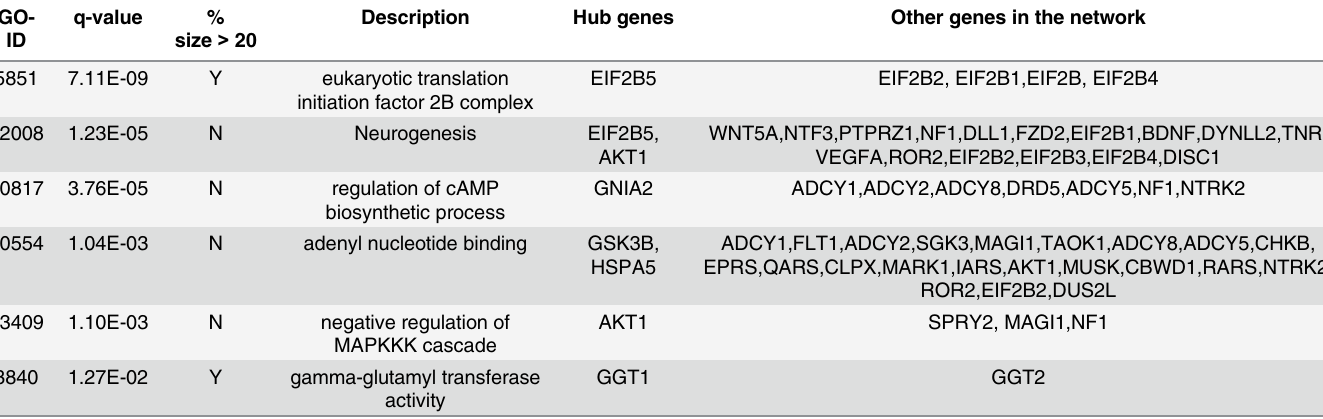
Table 10. GO enrichment analysis of stage-IV network.